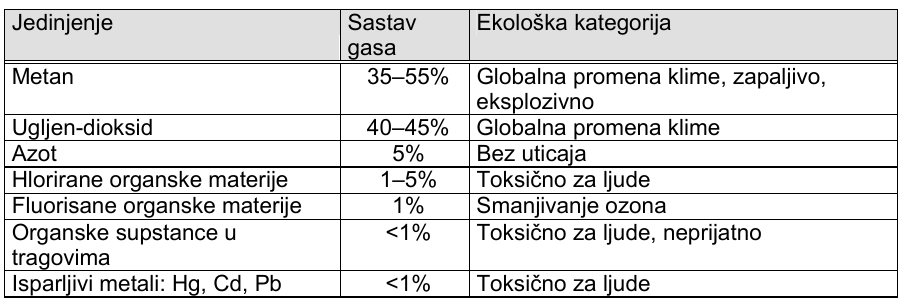
Emission into the air from a landfill